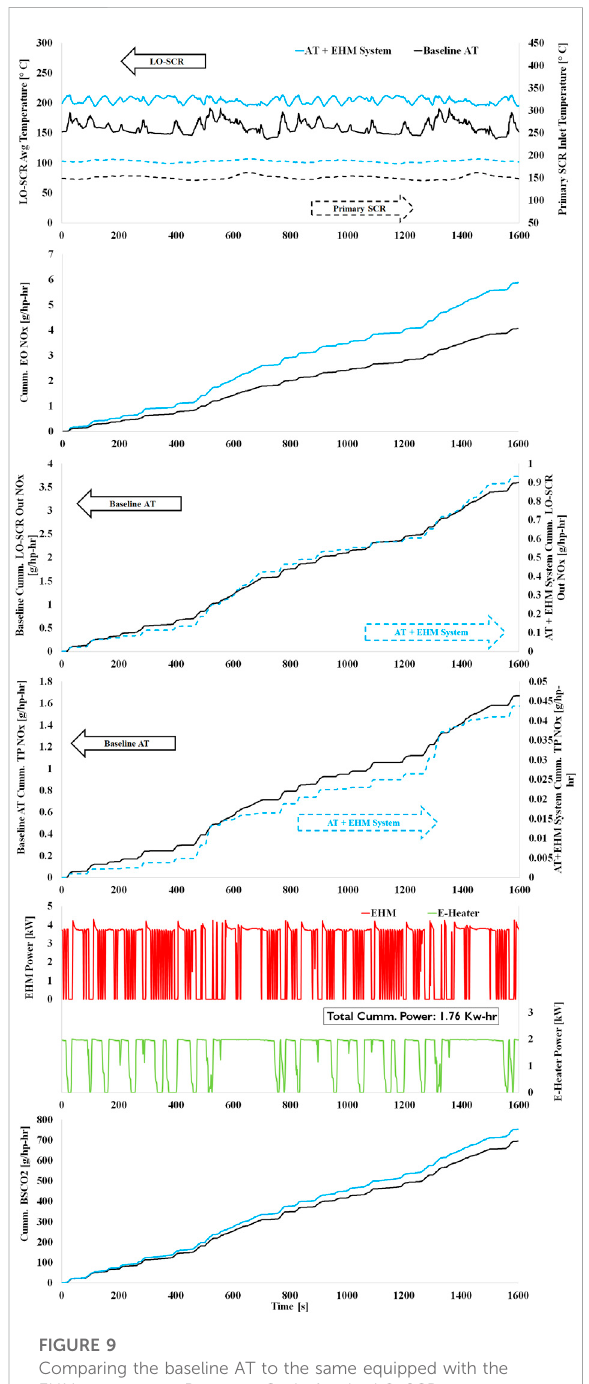
FIGURE 9 Comparing the baseline AT to the same equipped with the EHM system on a Beverage Cycle for the LO-SCR average temperature, primary SCR inlet temperature, EO NO x , LO-SCRout NO x , TP NO x , heater power consumption, and BSCO 2 .